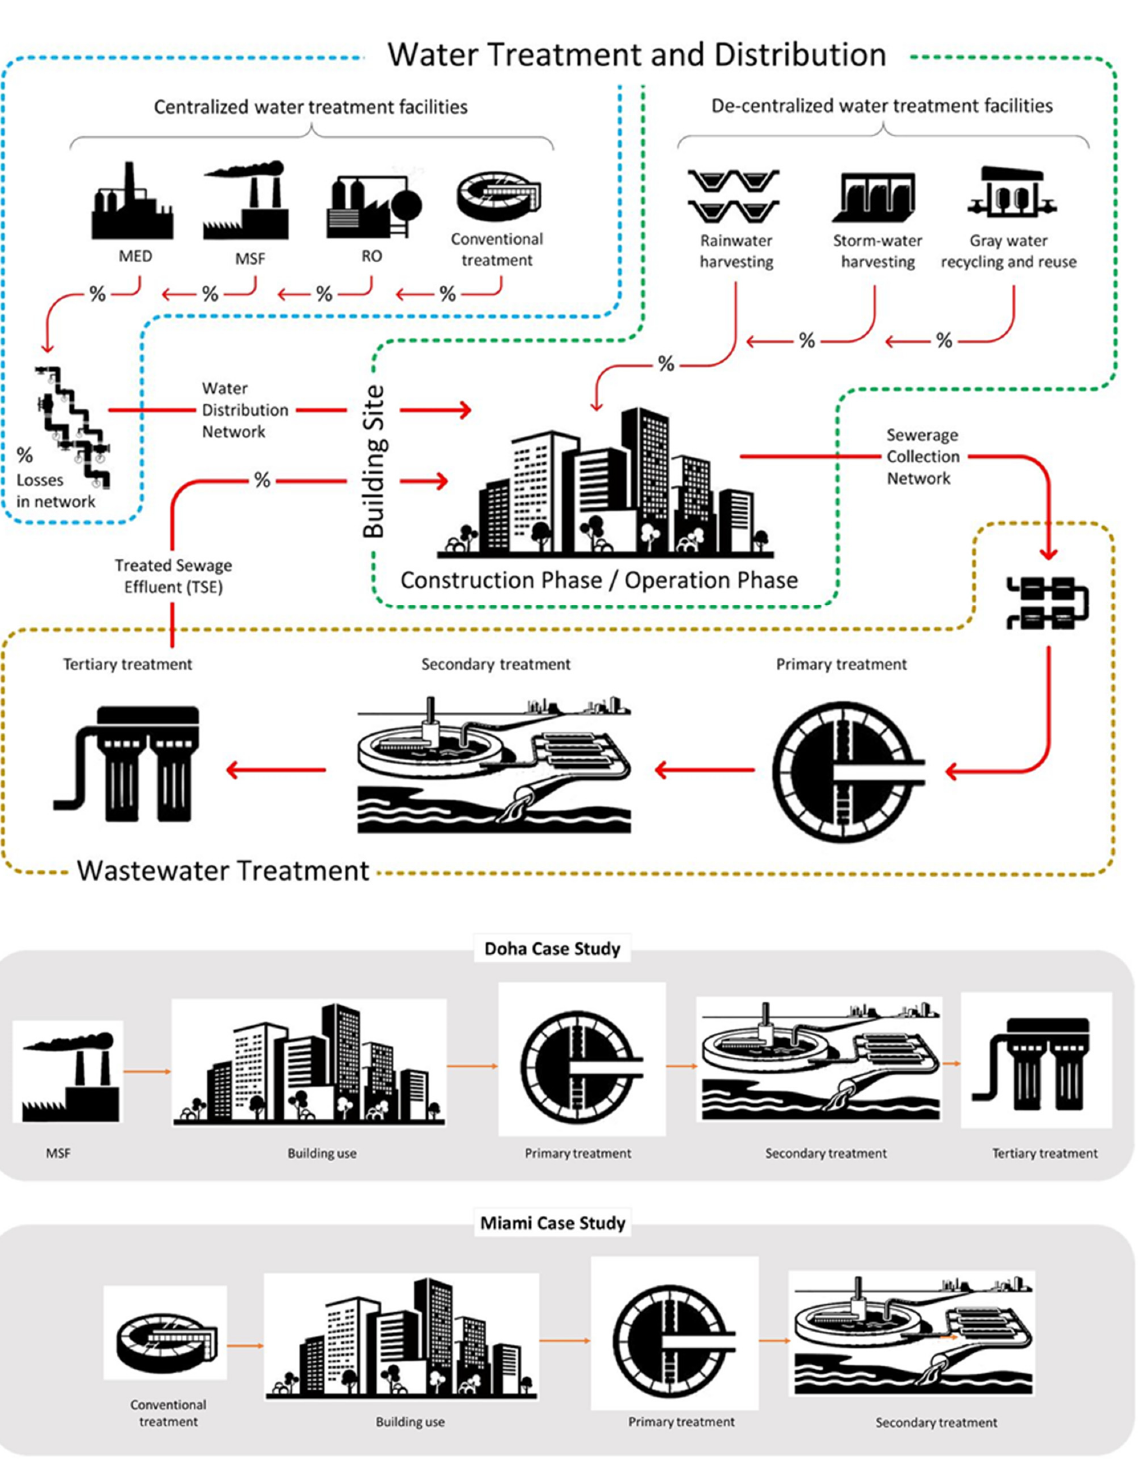
Figure 3. Simplified diagram of water use stages for residential buildings in both Doha and Miami. Top: the general water-use stages for built environments including various forms of treatment opportunities applied in different countries. Bottom: the specific water use cycle for Doha and Miami case studies showing the differences in water treatment and wastewater treatment stages.